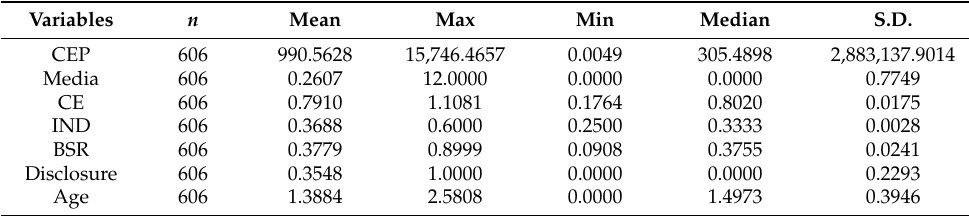
Table 2. Descriptive statistics of variables.